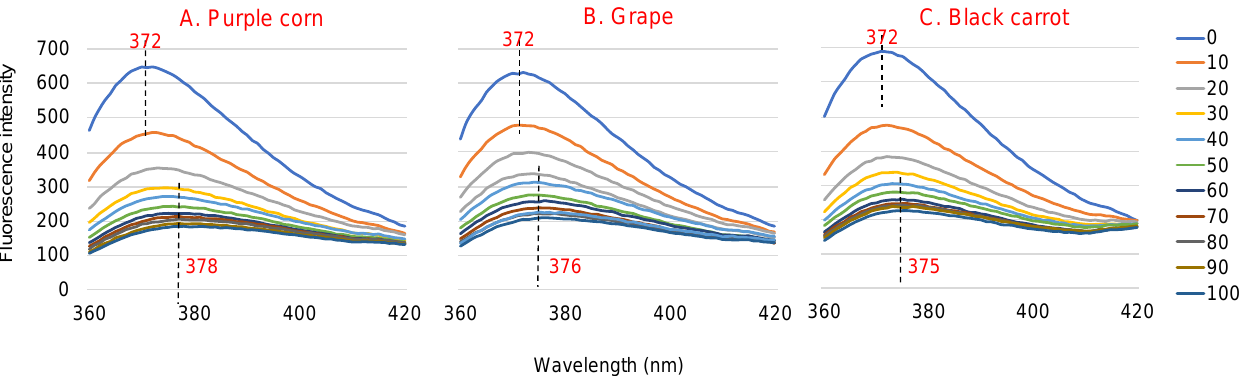
Figure 1. Fluorescence spectra of 3.6 μM native whey protein in the presence of 0~100 μM purple corn ( A ), grape ( B ) and black carrot ( C ) anthocyanin-rich extracts at an excitation wavelength of 280 nm at 25 °C and pH 3.